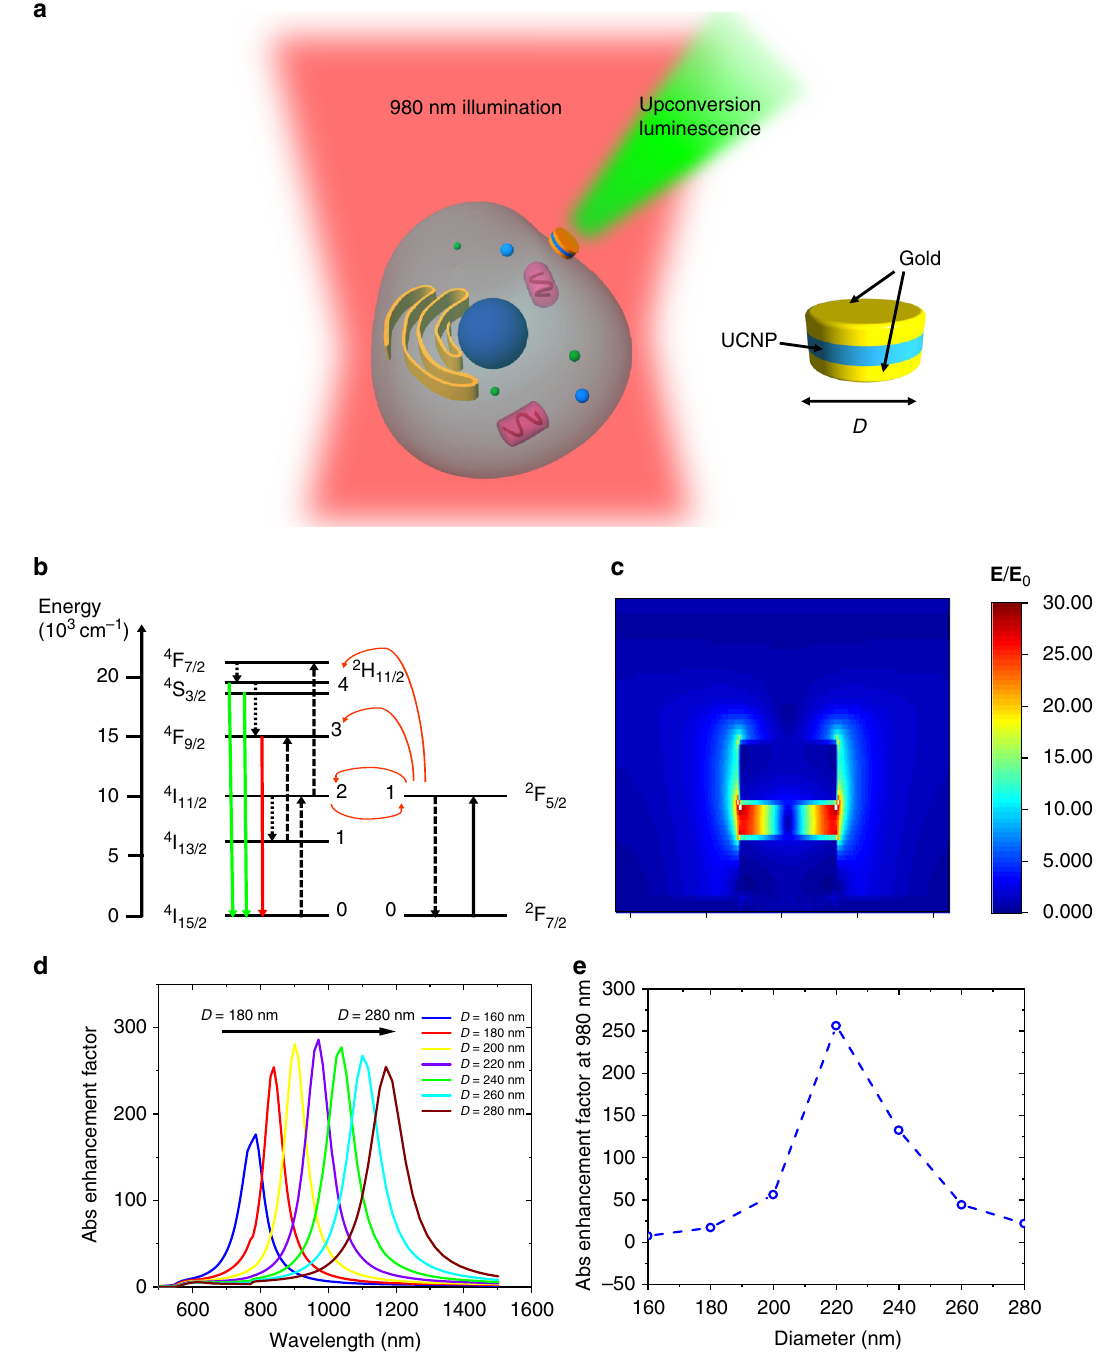
Fig. 1 Design of dispersible metal – insulator – metal nanostructure. a Schematic of metal – insulator – metal (MIM) nanostructure. The top and bottom gold layers squeeze the light into the upconversion nanoparticle (UCNP) insulator layer resulting in a highly localized fi eld that enhances the upconversion process. Poor adhesion between the gold and silicon substrate allows for easy lift off and dispersal into solution. MIMs can be functionalized and attached to cells for bioimaging. b Energy levels of donor Yb 3 + and acceptor Er 3 + ions relevant to upconversion process. UCNP absorbs 980nm light and emits upconverted green and red luminescence. c Simulated fi eld pro fi le under 980nm normal incidence plane wave excitation. E fi eld is normalized by incident plane wave amplitude E 0 . d Simulated diameter dependence of plasmonic resonance. MIM diameter can be used to tune resonance to any desired wavelength with large absorption enhancement occurring over a wide range of excitation wavelengths. e Simulated absorption enhancement factor at 980nm for various